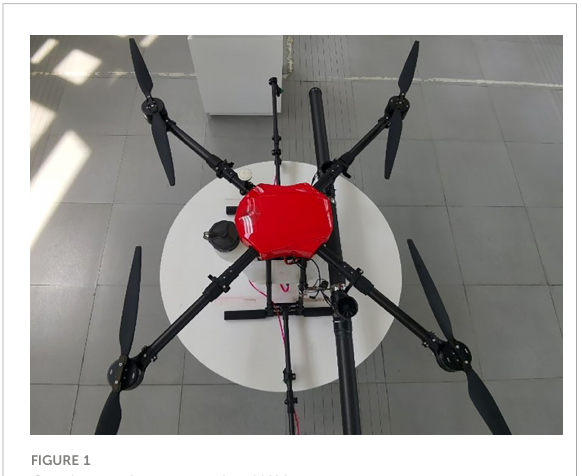
FIGURE 1 Quadrotor plant protection UAV.